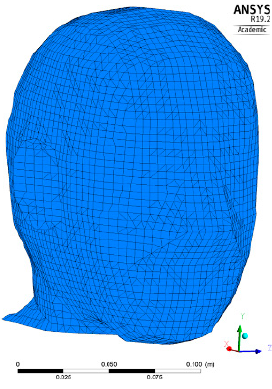
Figure 5. Face geometry.